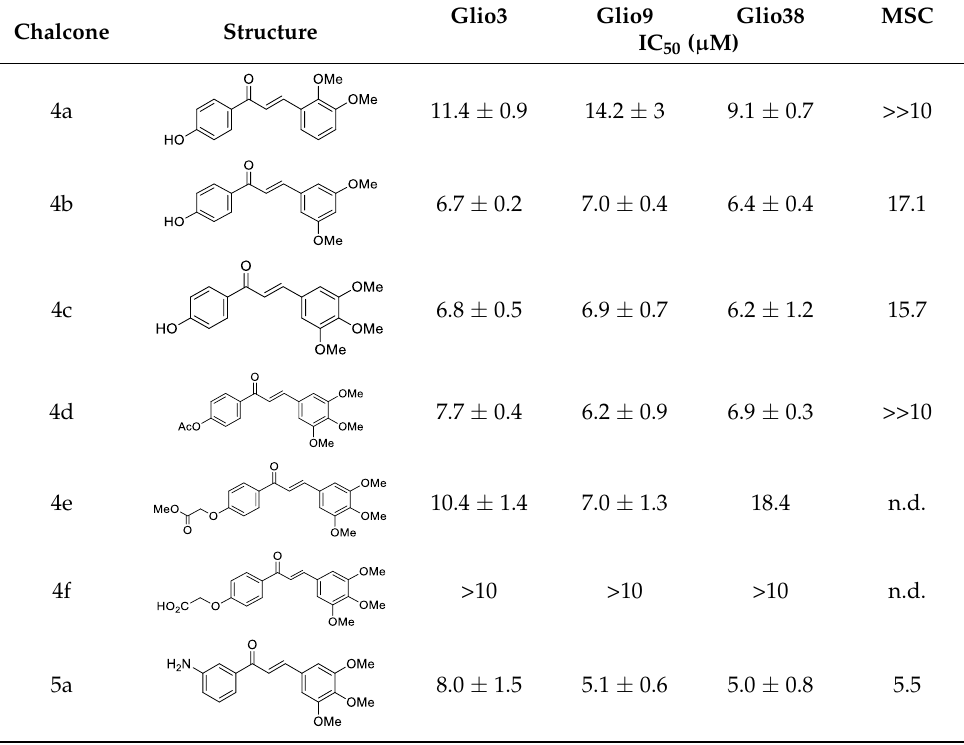
Structure and IC 50 (µM) of 4′ -hydroxyacetophenone and 3′ -amino chalcone derivatives in GSC lines Glio3, Glio9, Glio38 and mesenchymal stem cells (MSC). Data presented as IC 50 concentration ± SEM. >10 indicates chalcones with an IC50 of above 10 µ M. >>10 indicates no cell death observed at any of the concentrations tested and therefore IC 50 could not be determined. Not done (n.d.).